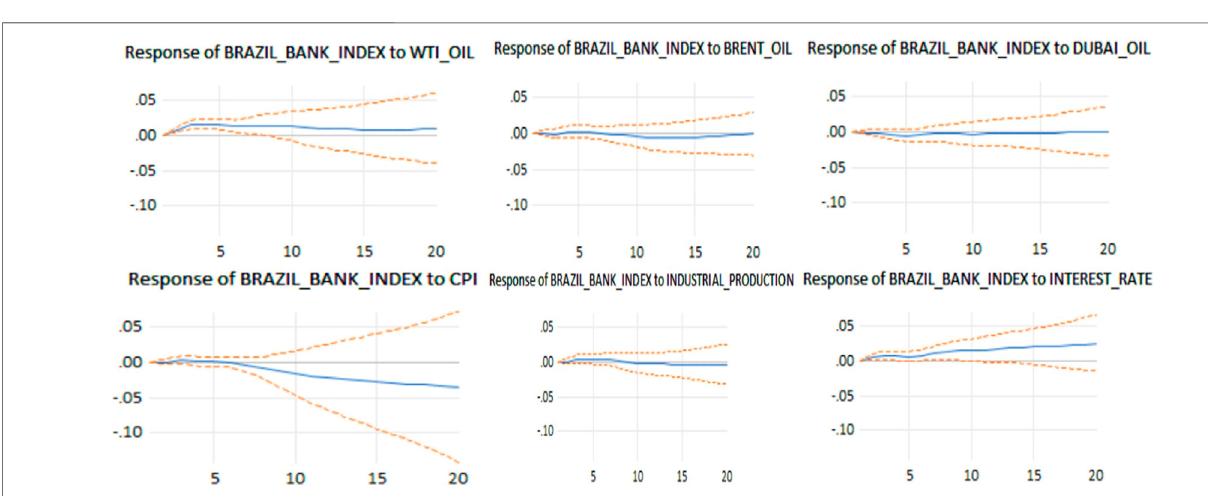
Frontiers in Energy Research |